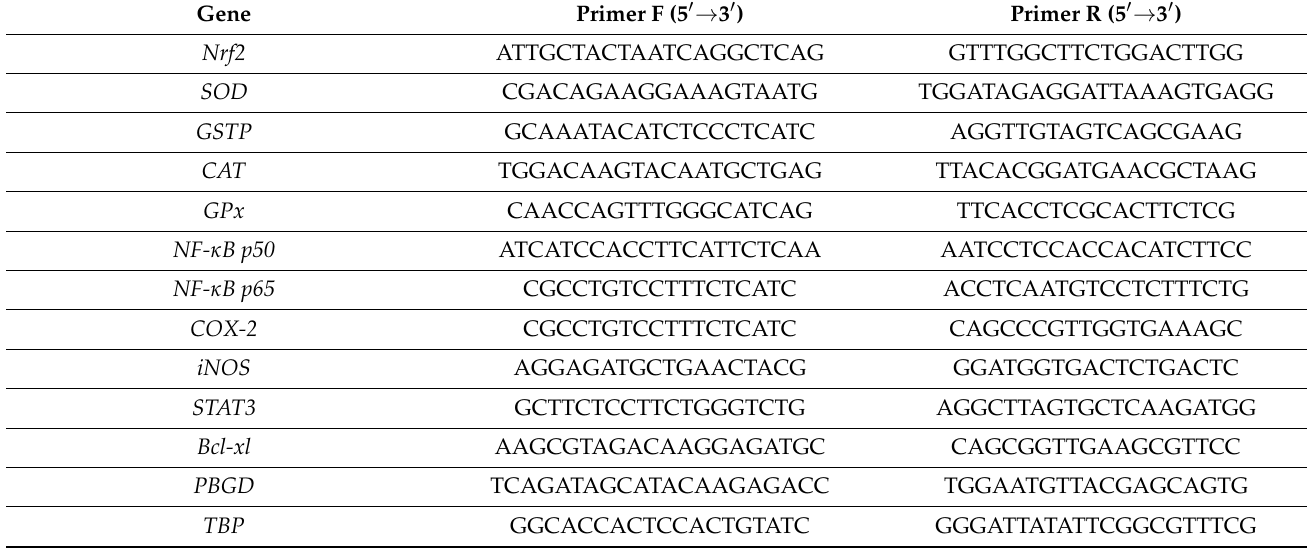
Table 1. The sequences of primers used in the real-time PCR reactions.